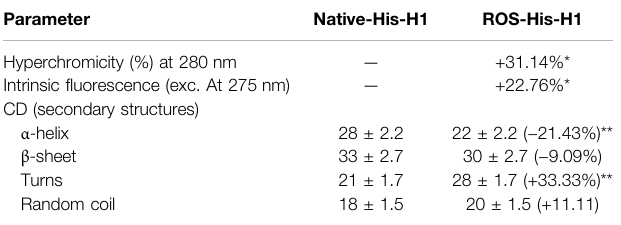
TABLE 2 | Biophysical characterization of ROS-His-H1 protein.